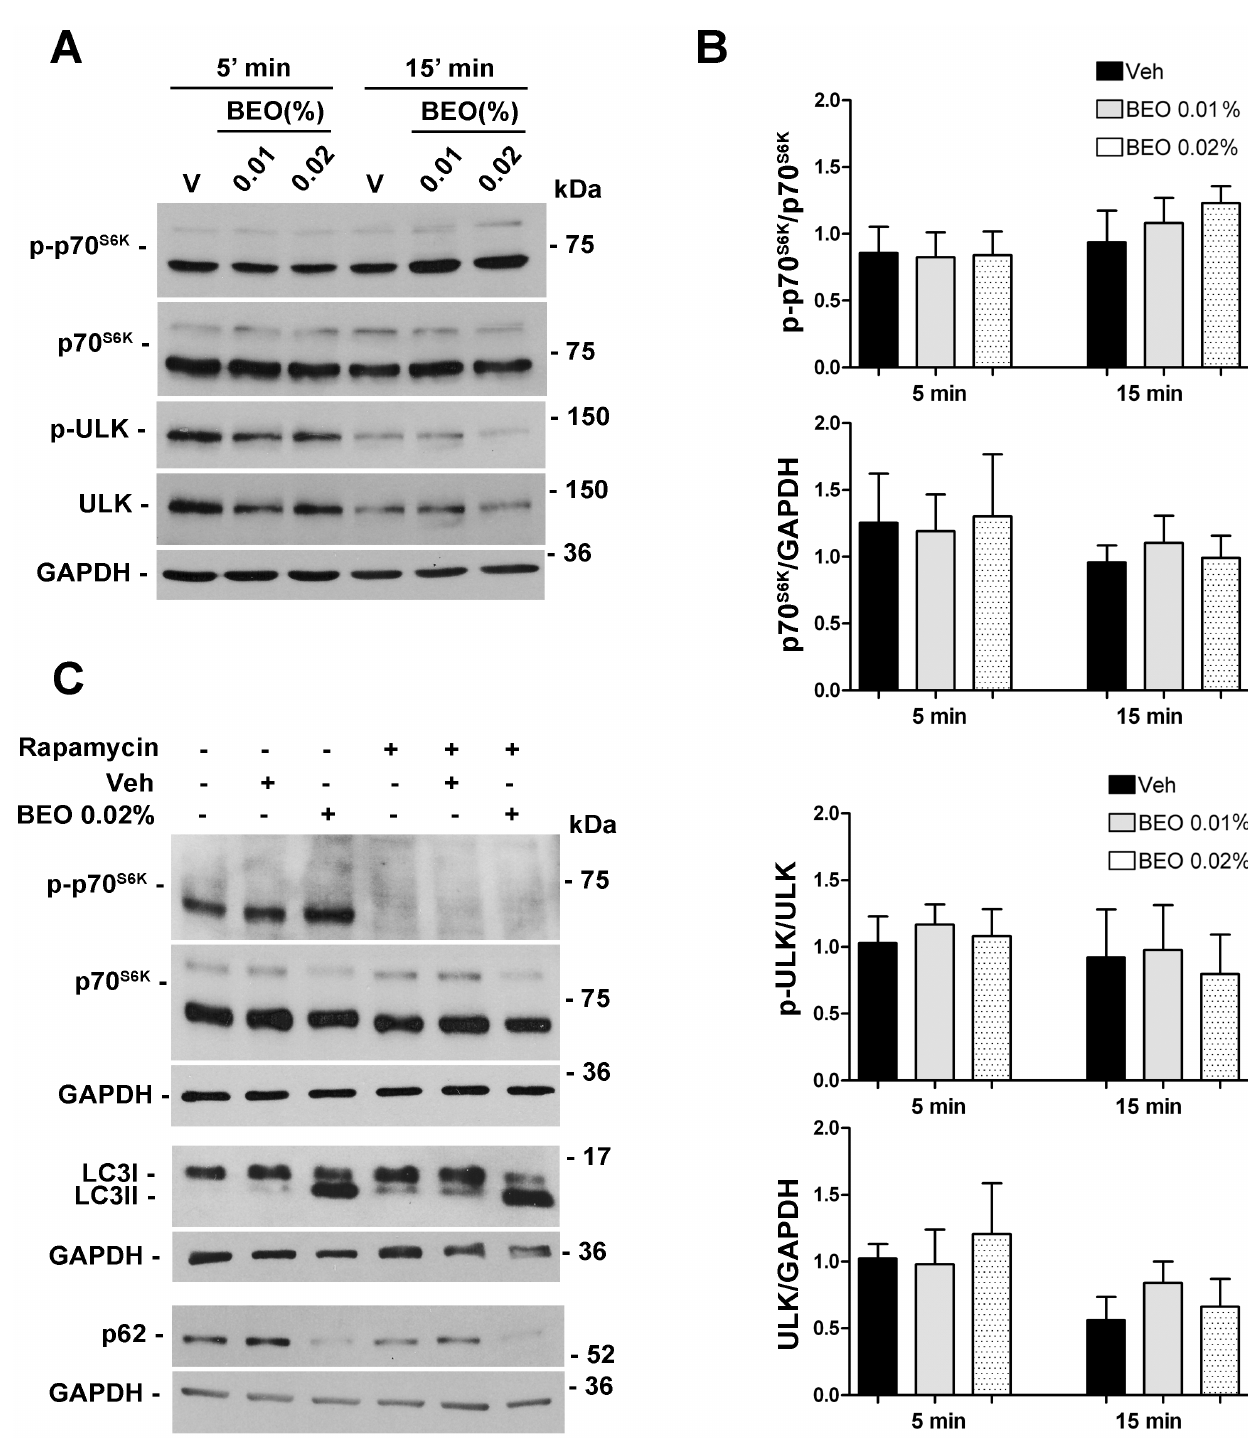
PLOS ONE | DOI:10.1371/journal.pone.0113682 November 24,